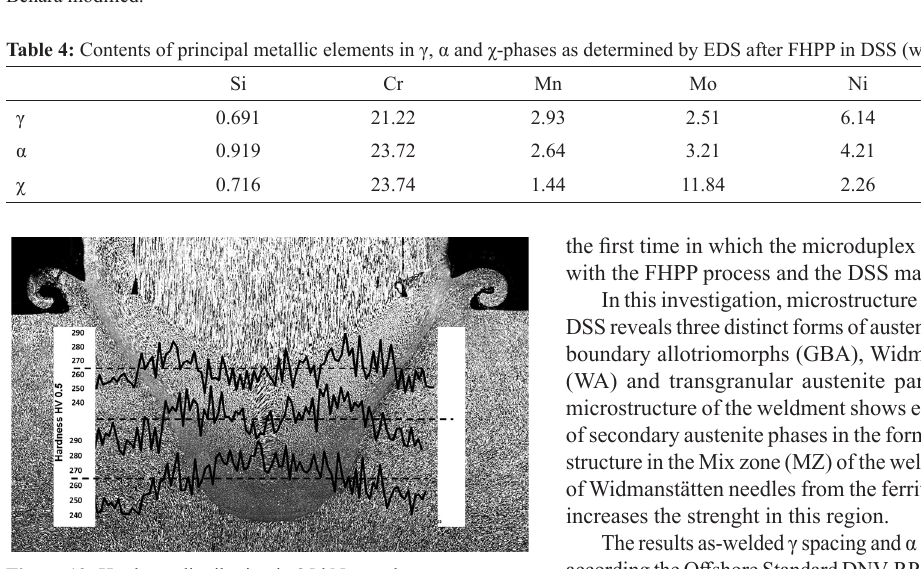
Figure 13: Hardness distribution in 25 kN sample. standard requirements as welded joint because was the only with a complete mixing and bonding without